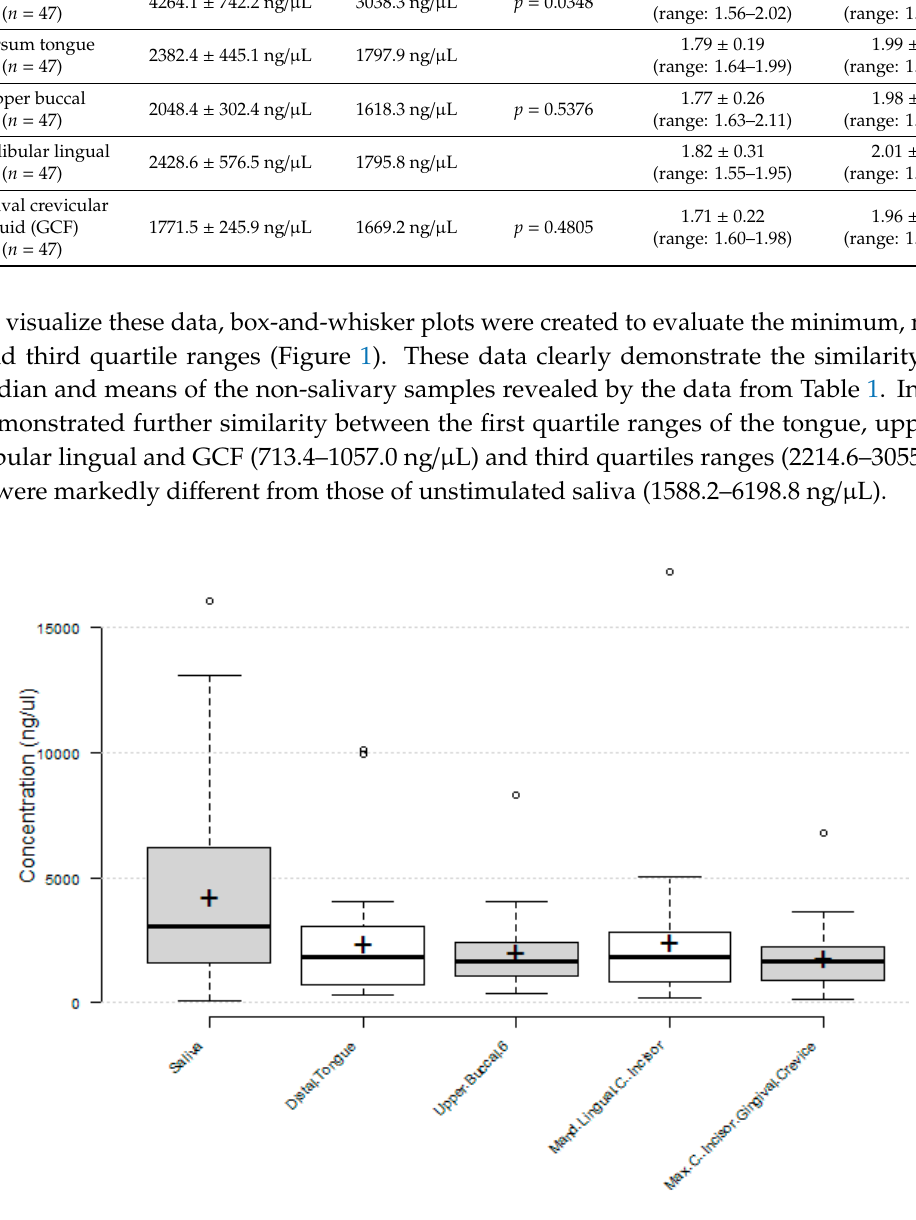
Figure 1. Box-and-whisker plot analysis of DNA from oral sampling sites. The Tukey method used to plot the interquartile range (IQR) between the 25th and 75th percentile reveals similarities between the DNA concentrations derived from biofilm and GCF, which were significantly lower than those derived from unstimulated saliva ( p = 0.0348).